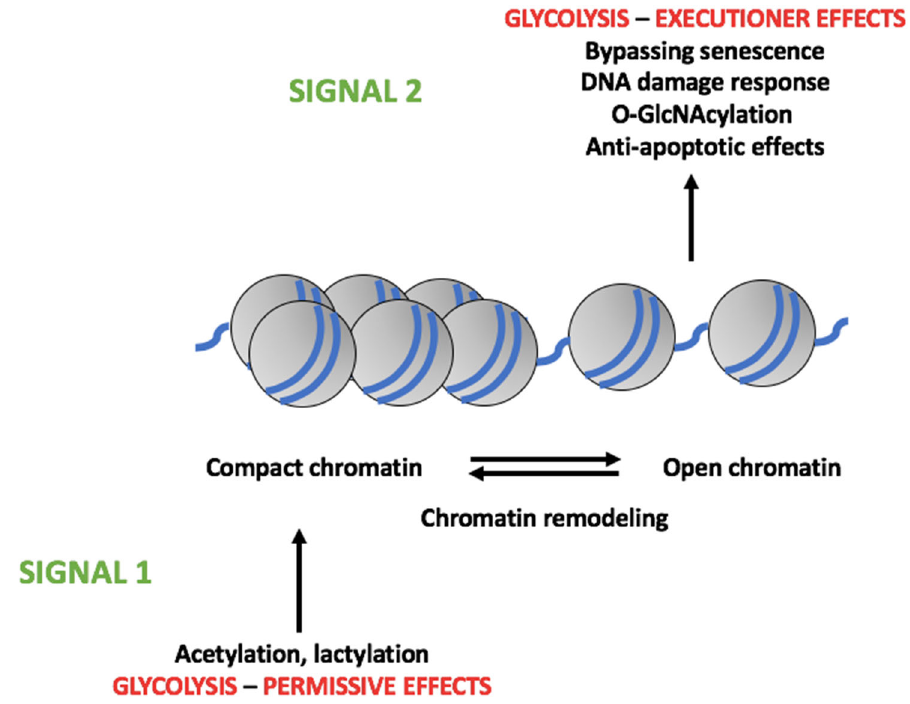
Figure 3. Effects on Early Tumorigenesis Induced by Glycolytic Enzymes and Metabolites. Glycolytic metabolites (e.g., pyruvate and lactate) may induce chromatin remodeling as a result of histone acetylation and lactylation. We refer to these as permissive effects or signal 1. These effects are necessary for the induction of what we call executioner effects or signal 2, i.e., the eventual mediators of the biological effects instigating tumorigenesis: bypassing senescence, DNA damage response, O ‐ GlcNAcylation, anti ‐ apoptotic effects.